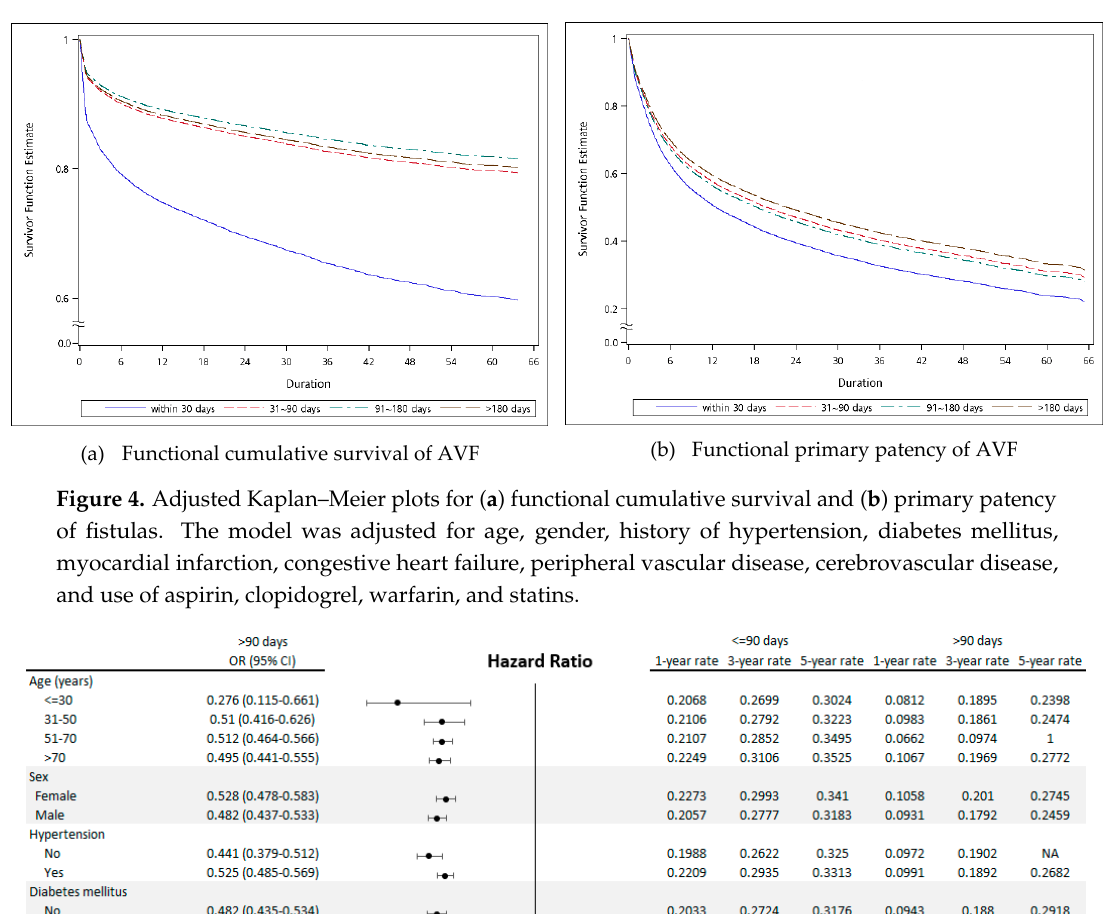
Figure 3. Functional cumulative survival and primary patency of fistulas